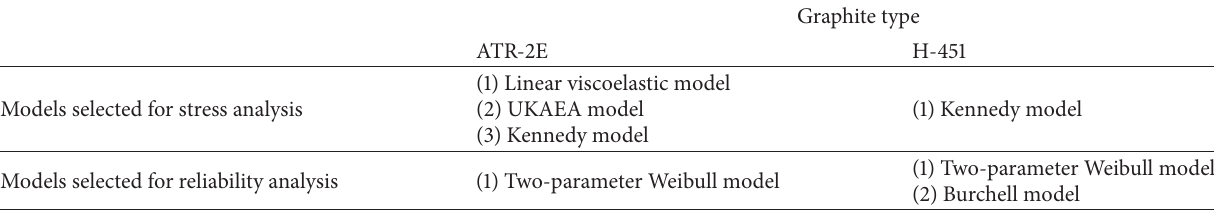
Table 1: Graphite type and model selection.